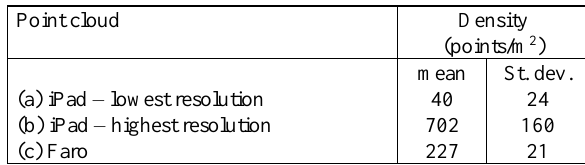
Table 6 . ICP co-registration results of the different iPad Pro dataset (A, B1 and B2) to the TLS scans (C).